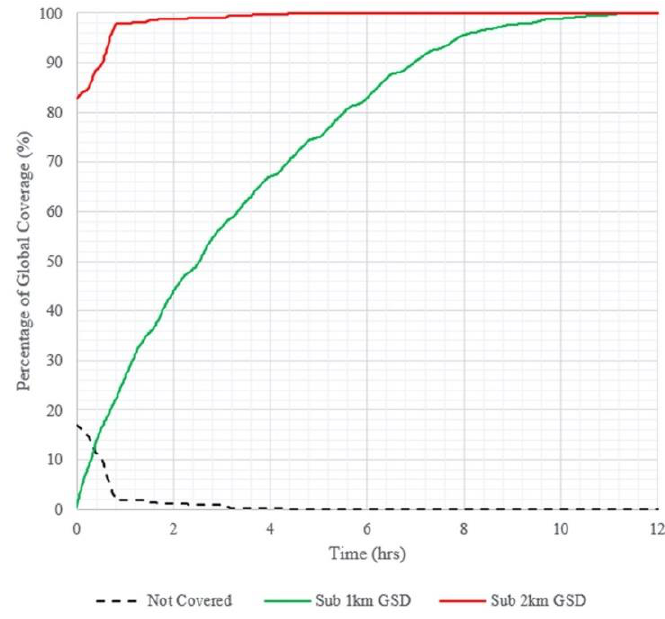
Figure 8. GEO coverage from GOES-16, GOES-17, Meteosat-8, Meteosat-11 and Himawari-8 in the ±60° latitude band.